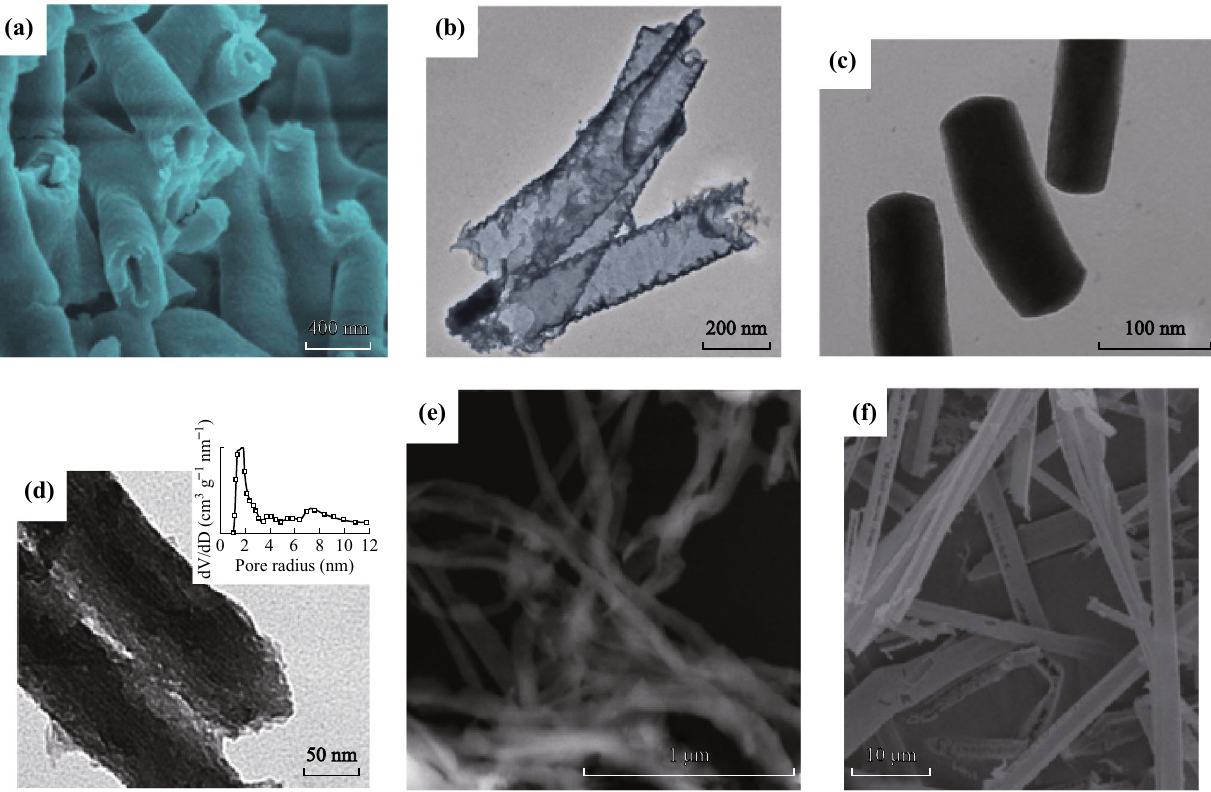
Fig. 5 1D g-C 3 N 4 nanostructures. a SEM image of nanotubes [79]. b TEM image of nanotubes [83]. c TEM image of nanorods [81]. d TEM image of porous nanorods [82]. Inset: pore size distribution. e SEM image of nanofibers [30]. f SEM image of tubular structures [85]. Reprinted with permission from Ref. [79] (Copyright 2014 The Royal Society of Chemistry), with permission from Ref. [83] (Copyright 2016 American Chemical Society), with permission from Ref. [81] (Copyright 2014 American Chemical Society), with permission from Ref. [82] (Copyright 2012 The Royal Society of Chemistry), with permission from Ref. [30] (Copyright 2013 American Chemical Society), with permission from Ref. [85] (Copyright 2016 Wiley–VCH Verlag GmbH),